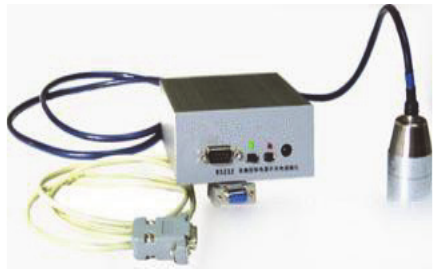
Figure 4: TOPBOX-508 vibration signal recording